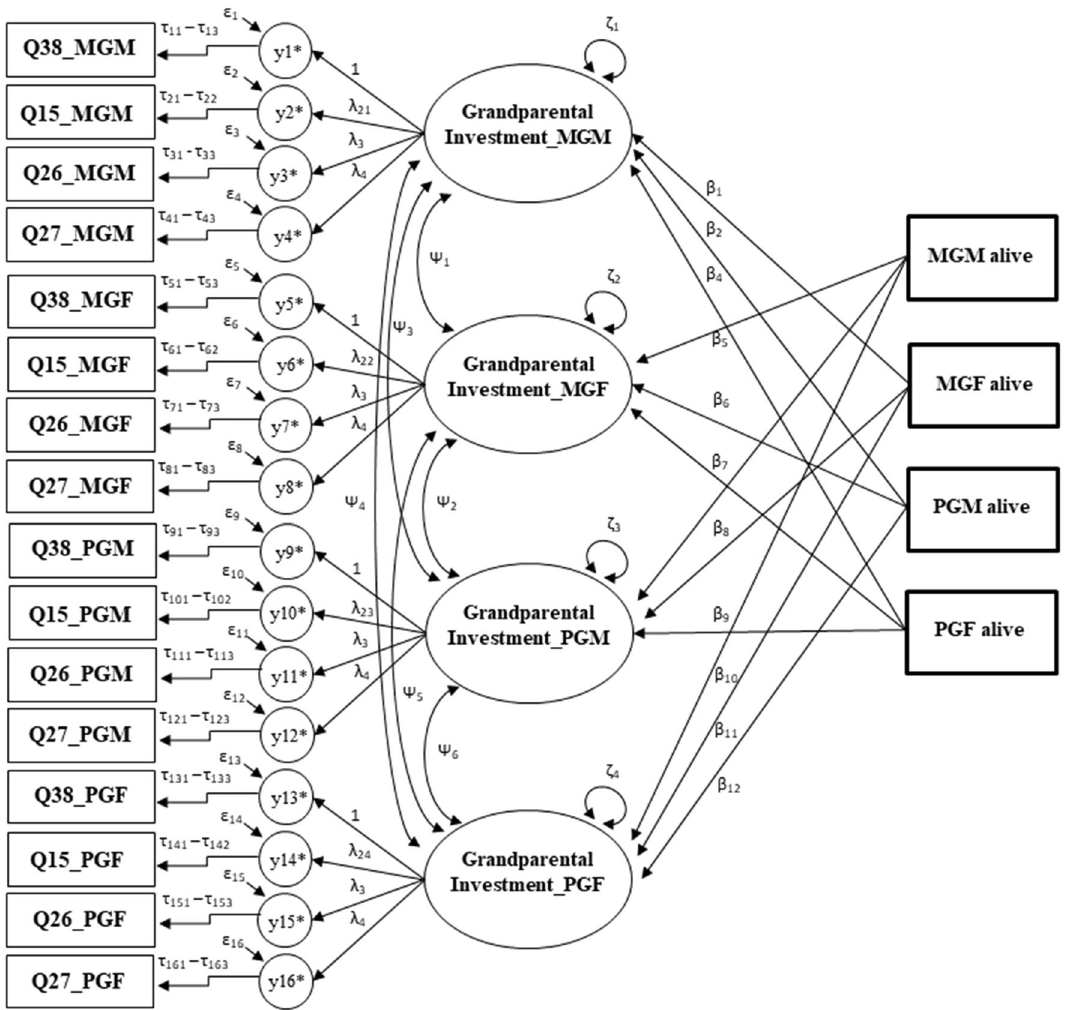
Figure 1. A graphical representation of the structural equation model used to examine how the survival status of other grandparents influenced a focal grandparent’s investment in their grandchild. Observed variables are represented as boxes (please note that the covariate grandchild age is omitted here for simplicity) and unobserved latent variables as circles. Single-headed straight arrows have three functions here: (i) when pointing from a latent variable to another latent variables (i.e., underlying normally-distributed latent variable (e.g., y1*– y4*) for each observed question per grandparent (Q15: “how often do you see them”, Q26: “their grandparents had looked after them”, Q27: “they could depend on their grandparents” and Q38 “provided financial assistance”. The suffixes _MGM, _MGF, _PGM and _PGF denote maternal grandmother, maternal grandfather, paternal grandmother, and paternal grandfather, respectively), they represent reflective linear loadings (λ’s) of the latent; (ii) when pointing at those underlying latent variables of the questions asked from grandchildren, they represent their unique residual errors (ε’s); and (iii) when pointing from observed independent variables to latent grandparental investments, they represent structural path coefficients (β’s). Single-headed arrows with a step denote a non-linear association, modeled as a probit link function by thresholds (e.g., τ 11 –τ 13 , τ 21 –τ 22 etc.), linking the latent variables and their indicators together. Double-headed arrows represents the error variances